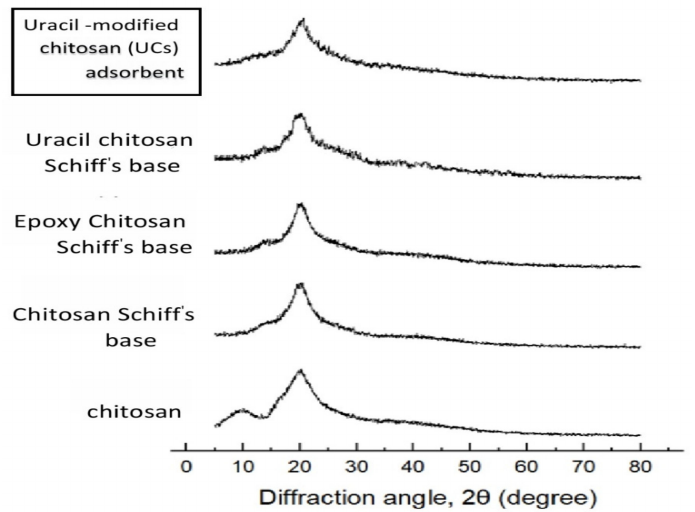
Figure 3. X-ray diffraction patterns of the modified chitosan derivatives.